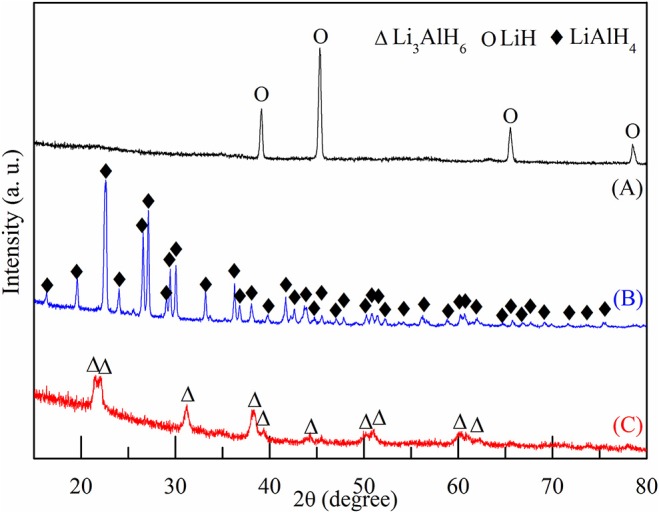
XRD patterns of (A) pure LiH, (B) pure LiAlH4, and (C) mixed powder of LiH and LiAlH4 after ball milling for 20 h.